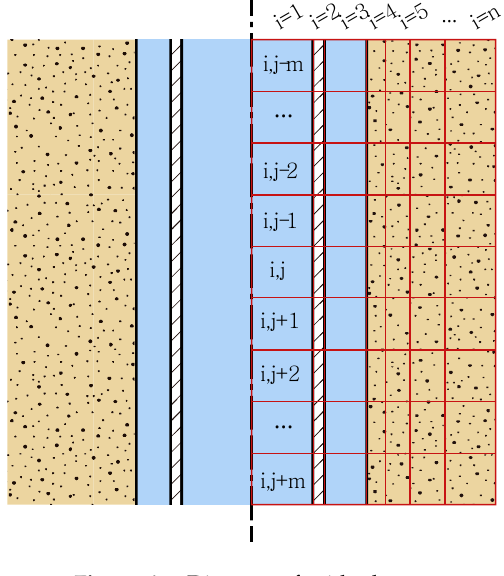
Figure A1. Diagram of grid scheme.